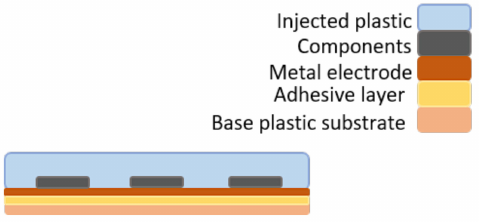
Figure 3. Typical materials stack. Table 1. Composition of different commercial copper cladding foils.